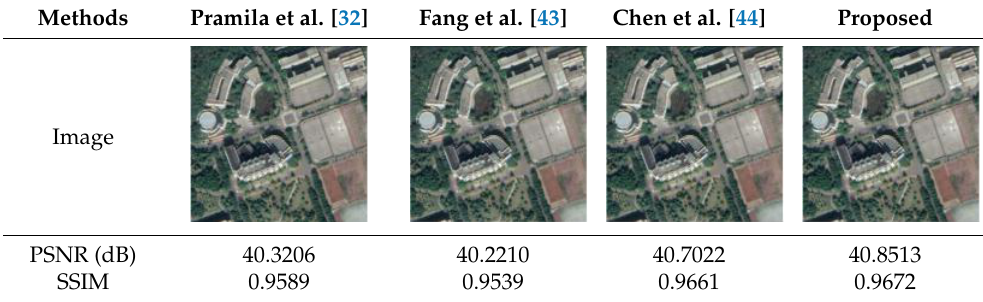
Table 7. Watermarked images generated by different methods.